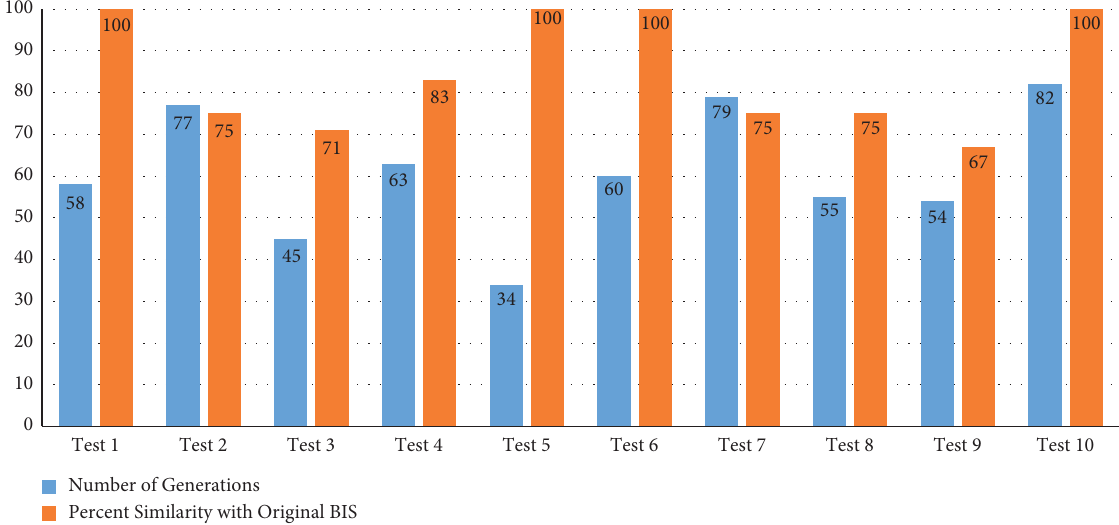
Figure 6: BISs recalculated ten times with the number of iterations for the base